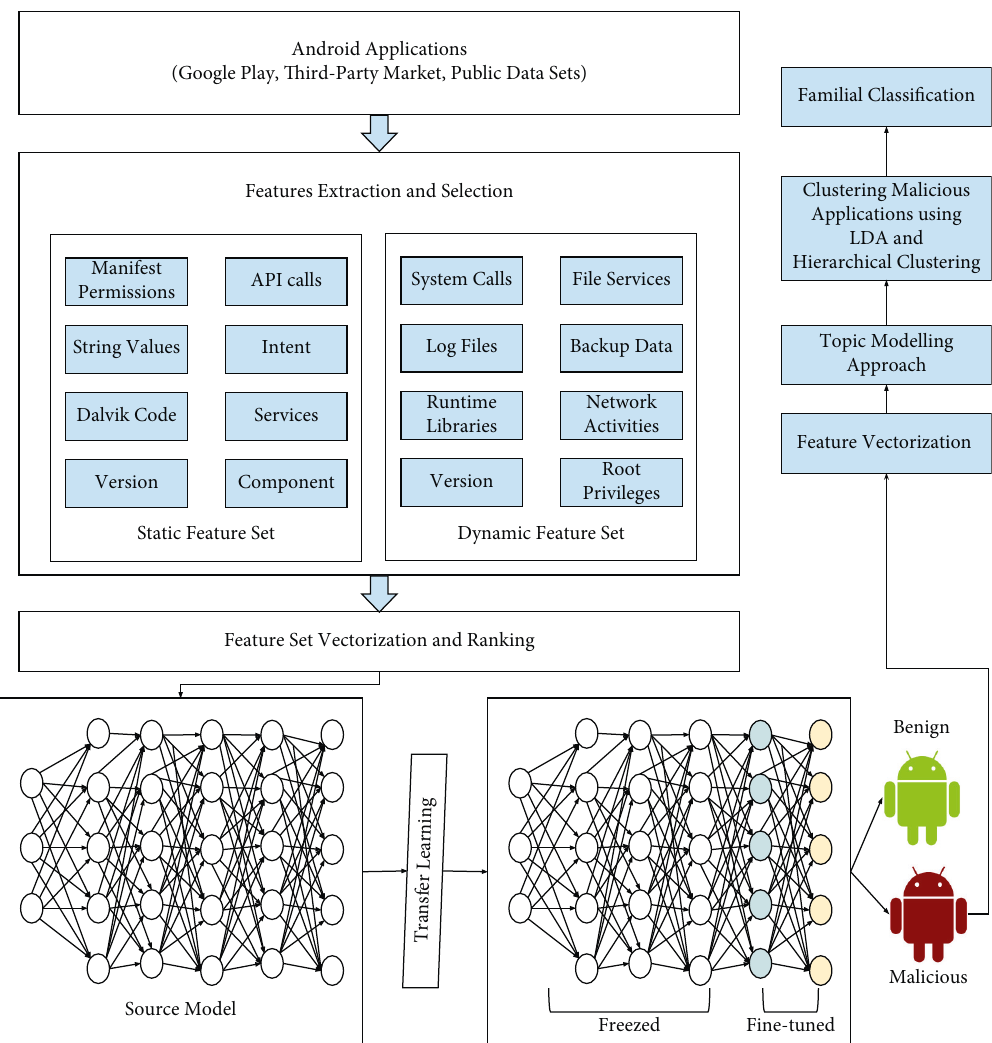
Figure 3: Proposed